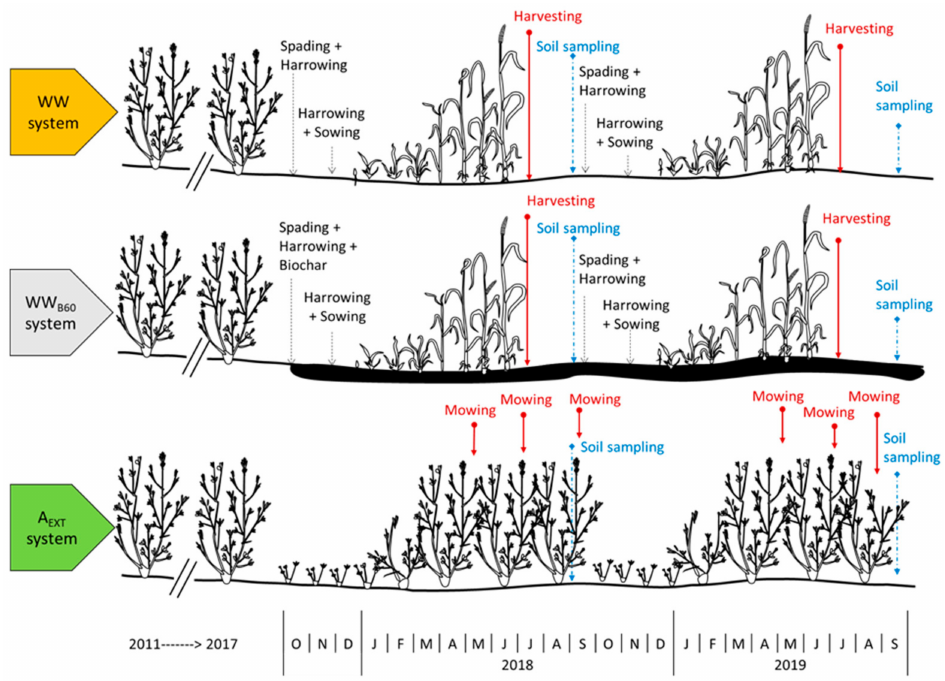
Figure 2. Management practices applied and samplings carried out for the different management systems during the study period (October 2017–September